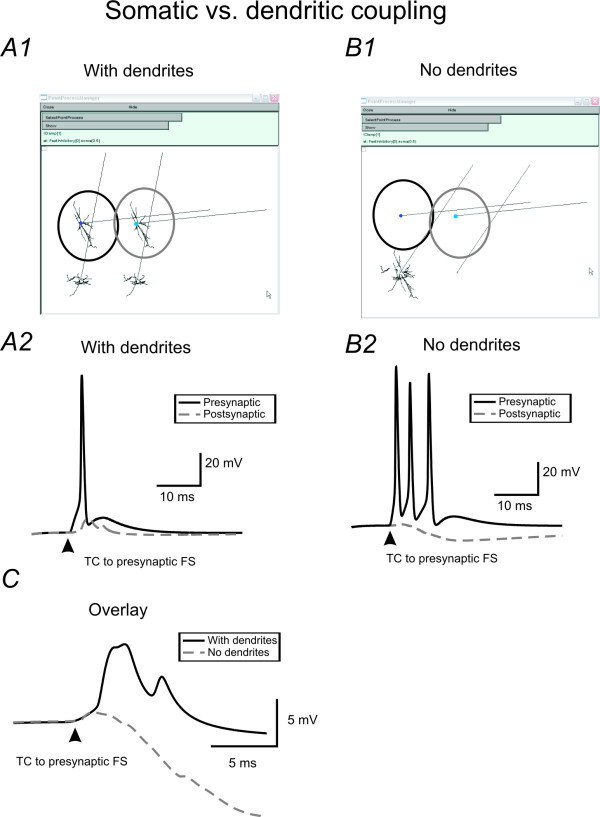
The value of GJ mediated conductance in real neuron may be underestimated due to dendritic coupling. A) The single cell responses in FS1 &FS0, induced by a TC stimulus applied to FS1. FS1 &FS0 were coupled via GJ (gGJ = 0.4 nS). B) Experimental conditions in B are exactly the same as A except that the dendrites were removed (see B1). Note that without dendrites (and dendritic GJs), the same TC stimulus induced responses in FS1 are more excitable, however, in the postsynaptic FS cell, the GJ coupled responses are smaller. C) Overlay of the GJ coupled responses in the postsynaptic FS cell, showing that the dendritic responses are ~7 fold larger with dendrites.